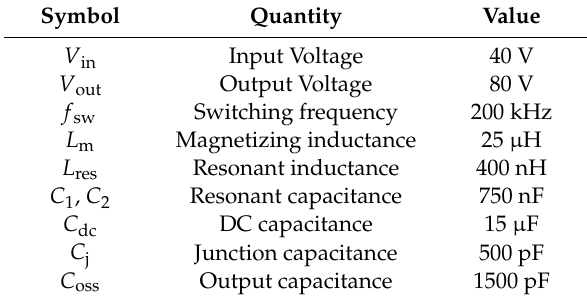
Table 2. Experimental parameters.